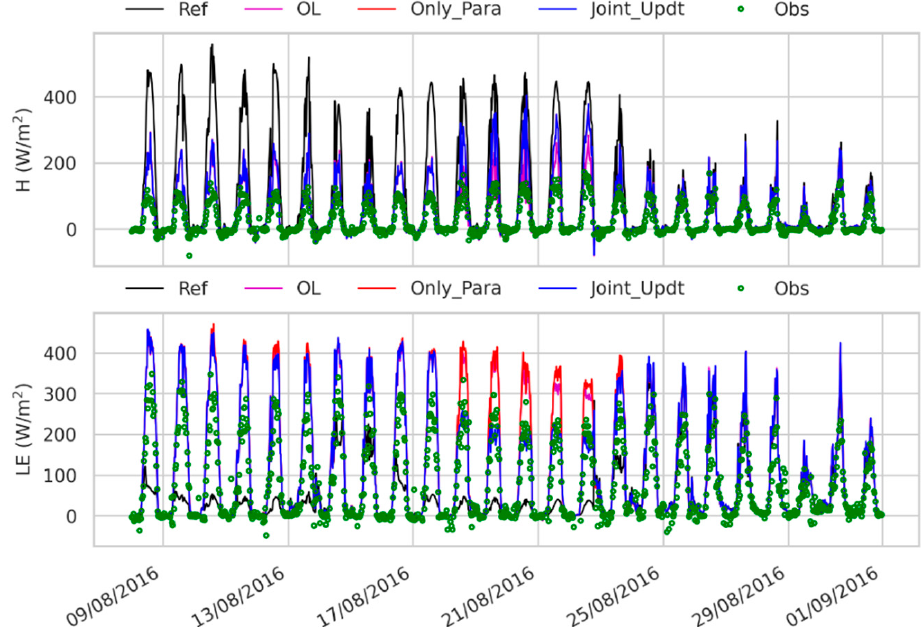
Figure 9. Comparison of estimated land sensible heat flux (H) and latent heat flux (LE) time series from 07 August 2016 to 31 August 2016 by the reference (Ref) experiment, open loop (OL) experiment, the scenario with only soil properties updated (Only_Para) and the scenario with both the soil properties and soil moisture estimates (Joint_Updt) updated with SMAP T H assimilation, to the in situ turbulent heat fluxes measurements by the eddy-covariance system deployed at the Maqu site